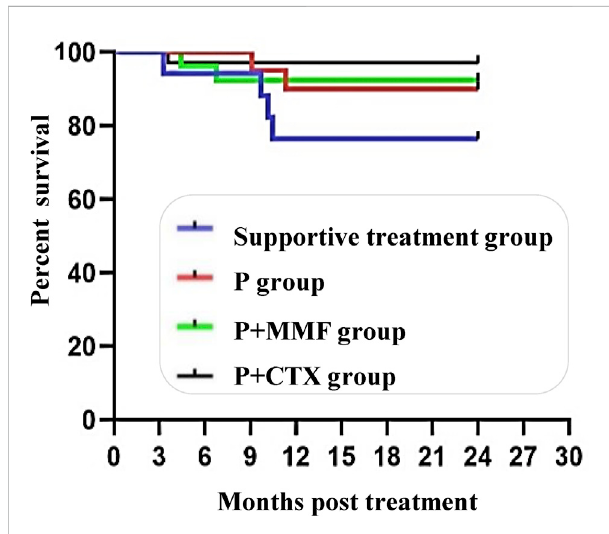
FIGURE 2 Survival curves of in different treament groups for severe